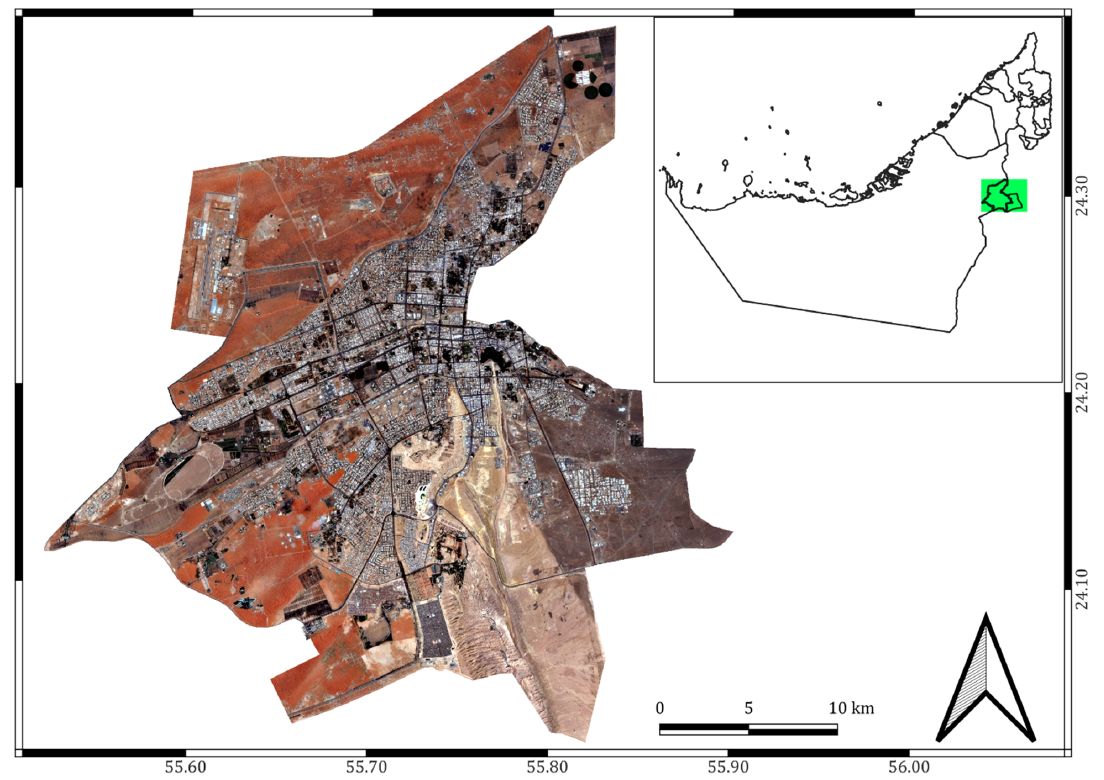
Figure 1. Location of the stud area: Al Ain Sentinel 2A image ( left ) and UAE map ( right ).